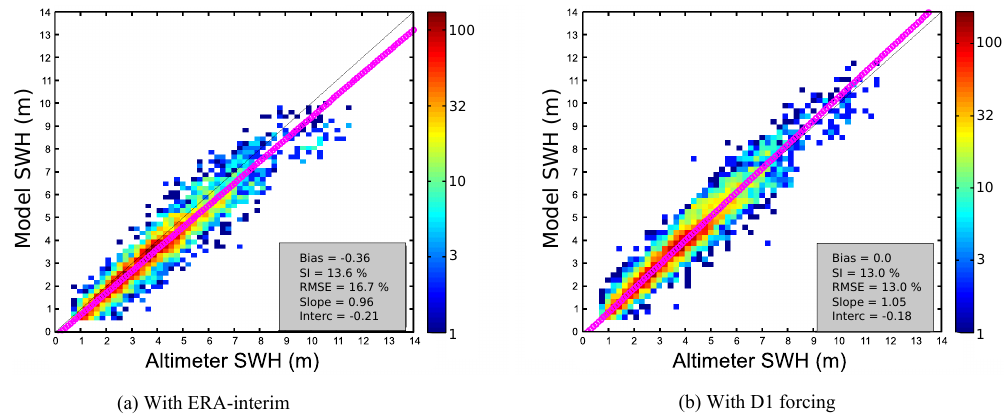
Figure 4. Scatter plots of significant wave heights (SWHs) of model MFWAM and altimeters (ENVISAT and Jason-1) for the 2004, 2007, 2008 and 2010 French storms. (a) and (b) stand for runs with interpolated ERA-Interim and D1 wind forcing, respectively.